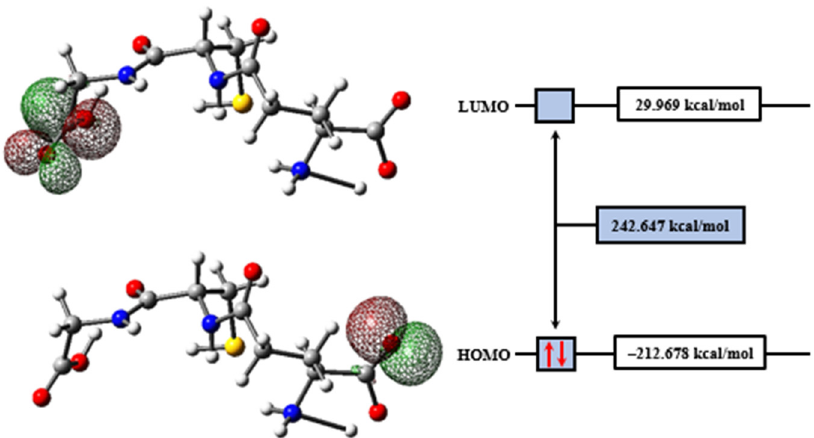
Figure 6. HOMO and LUMO plots for GSH calculated at the M06-2X/6-311++G(d,p) level of the- ory.